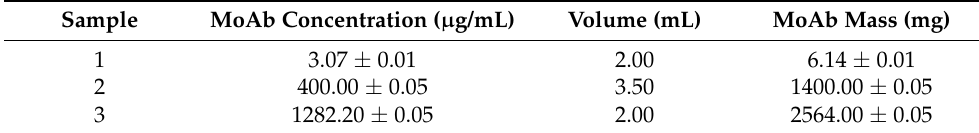
Table 1. Characteristics of purified MoAb fractions.